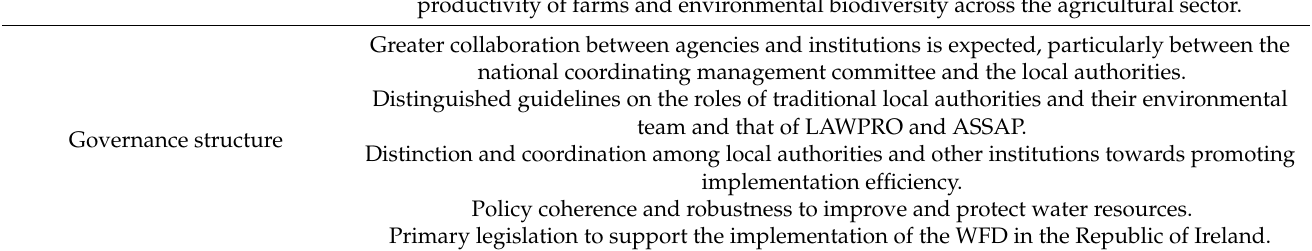
Communication and